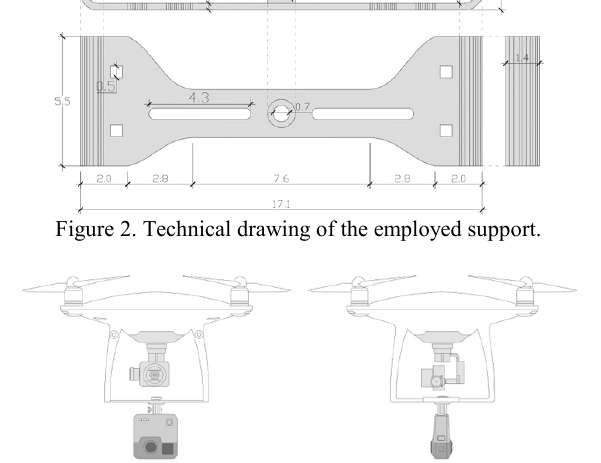
Figure 3. Installation scheme of the support on the Phantom.